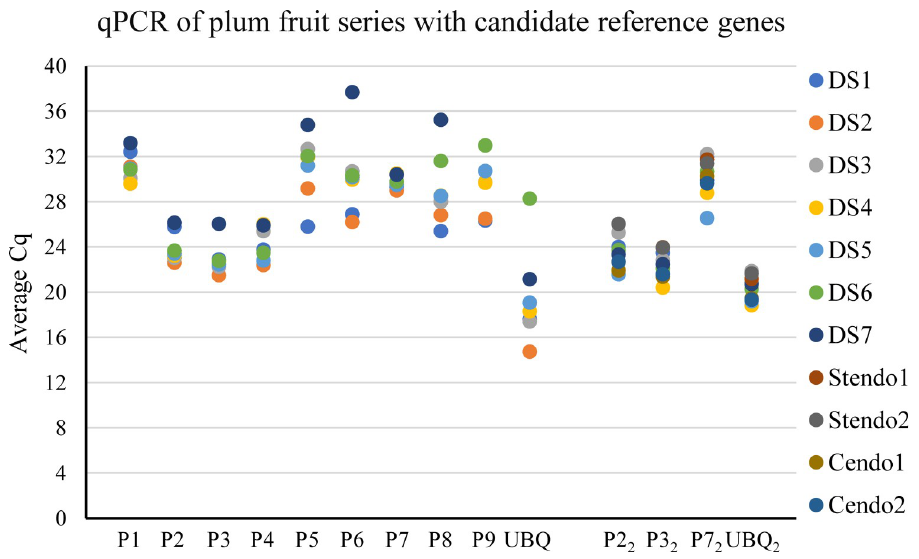
Fig 2. Cq results from qPCR of nine candidate reference genes and the standard UBQ with a small developmental series of plum early fruit RNAs. The Cq of each fruit development RNA (average of triplicate samples) is presented for each candidate reference gene. The list of RNAs (DS1-DS7, Stendo1,2 and Cendo1,2) is presented in S3 Table and list of candidate reference genes (P1-P9) is presented in Table 2. qPCRs with the subscript 2 on the X axis represents a new RNA extraction of fruit development that included the endocarp tissues and was assayed with the three most stable of the candidate reference gene as well as UBQ. UBQ represents the UBIQUITIN10 gene. Primer sets for the reactions are listed in S4